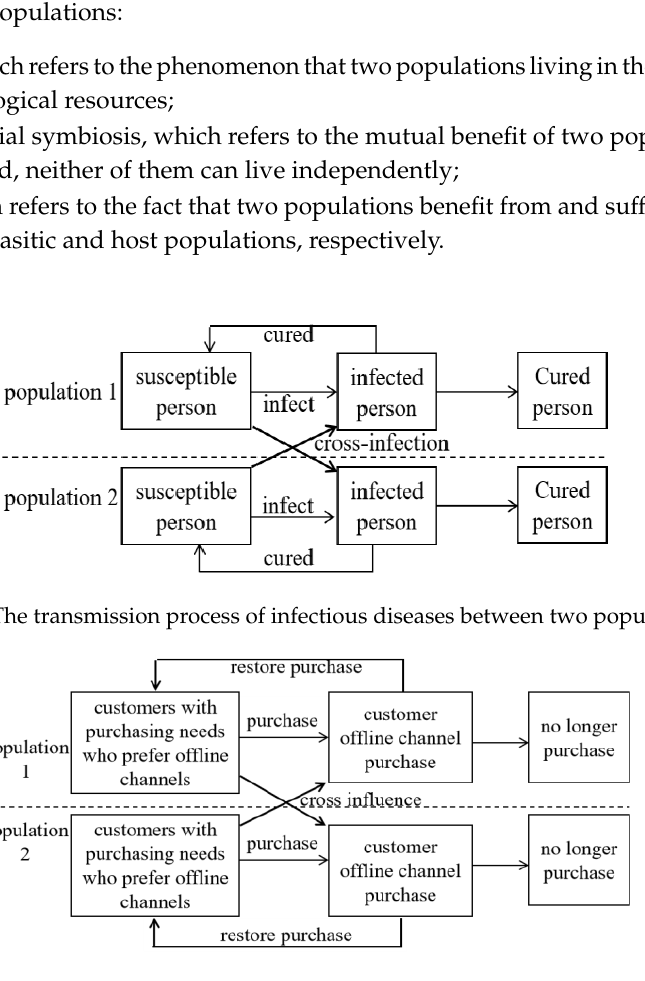
Figure 2. The customer’s purchase process in the pharmaceutical dual-channel supply chain.